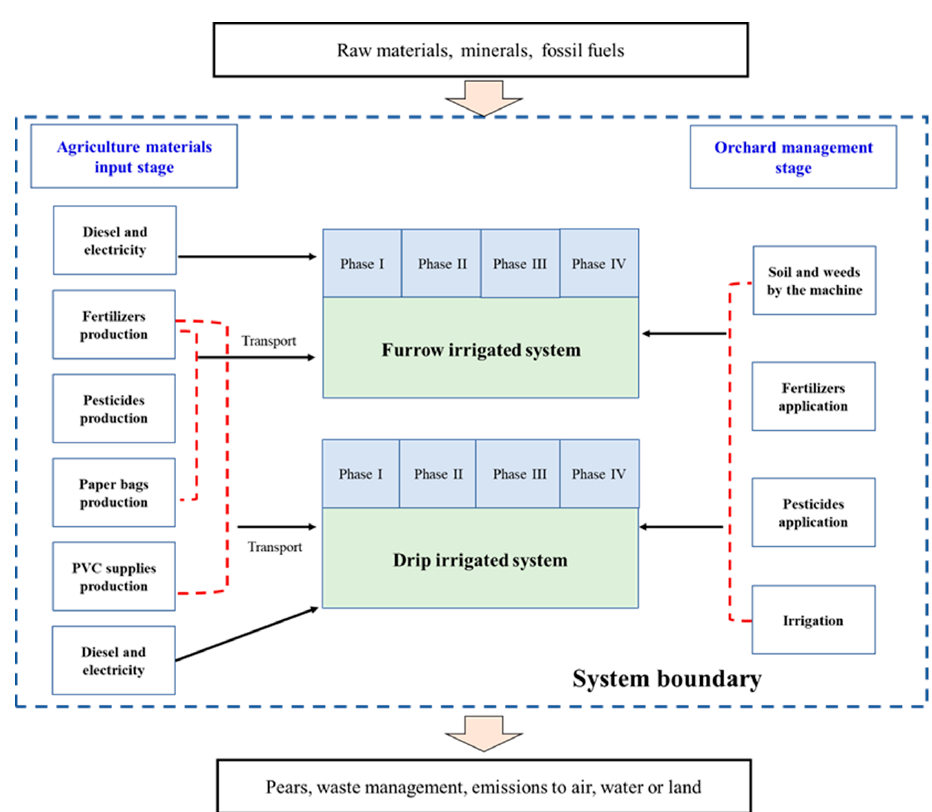
Figure 1. Life cycle and system boundaries of pear production by the furrow and drip irrigated systems in Loess Plateau of China.